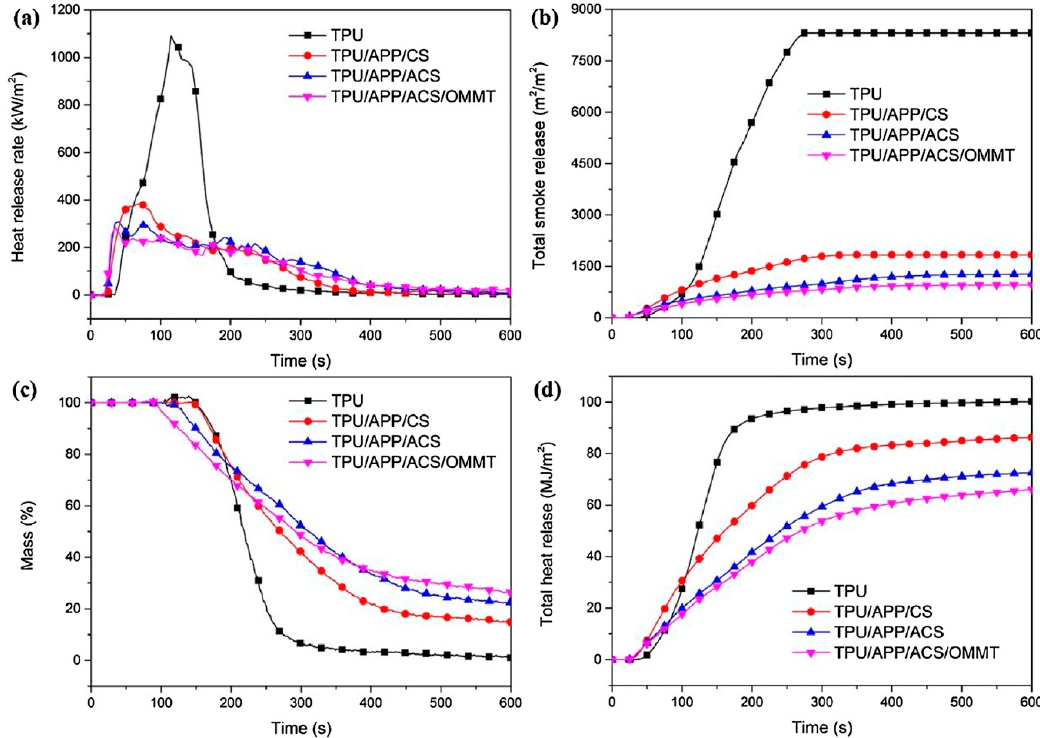
Figure 2. HRR—Heat Release Rate ( a ), THR—Total Heat Release ( b ), Mass loss ( c ) and TSR—Total